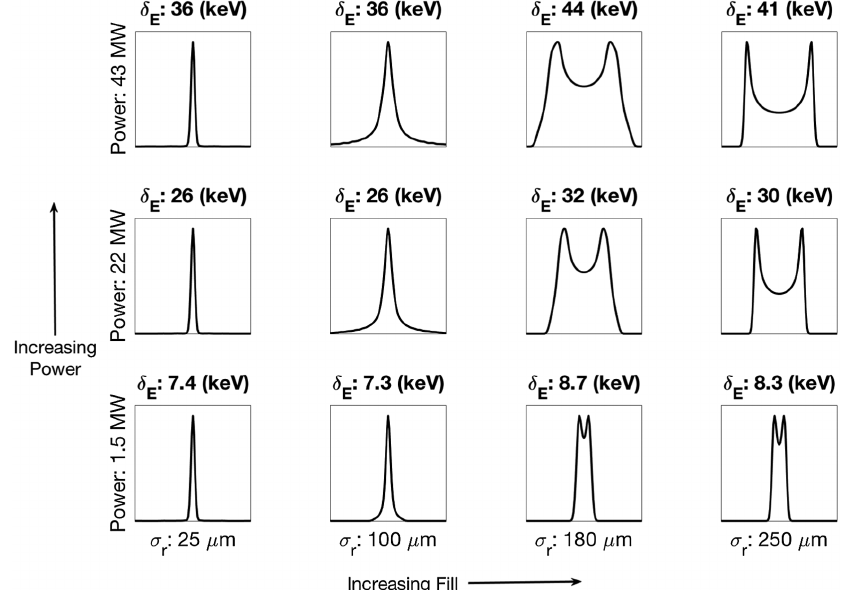
value.FIG. 5. Energy distributions and their averaged rms energy spread ( δ ) over a sweep of beamlet waist with a fixed distance between E beamlet centers, defined as fill factor. Large δ values for thin distributions are due to small aberrations at high δ 0 due to large laser E power but small probability of interaction. Plots are normalized with respect to maximum